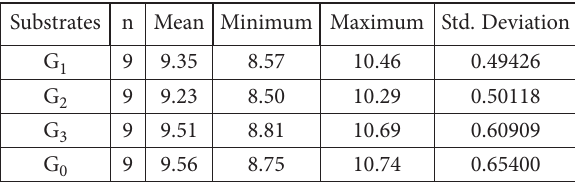
Table 2. pH values according to substrates Subs trates n Mean Minimum Maximum Std.